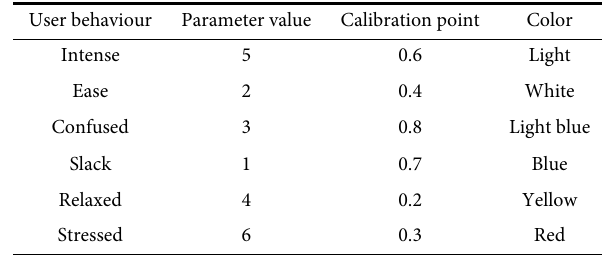
Table 2 User characteristic behaviour of eye movement detection on 3D game console: Overlapping colors tend to blend to give a unique hue.